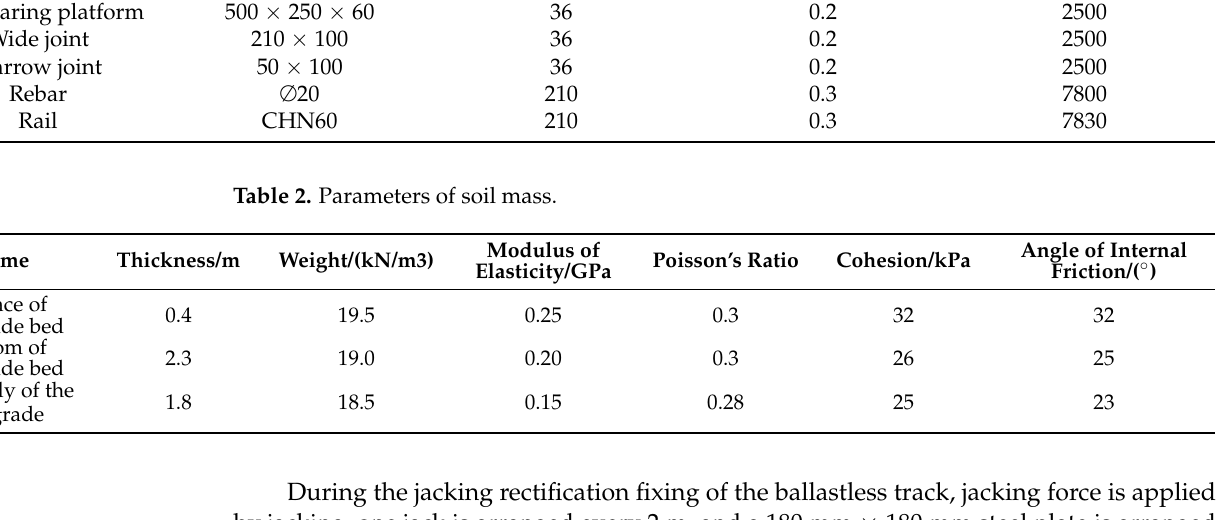
Table 2. Parameters of soil mass.